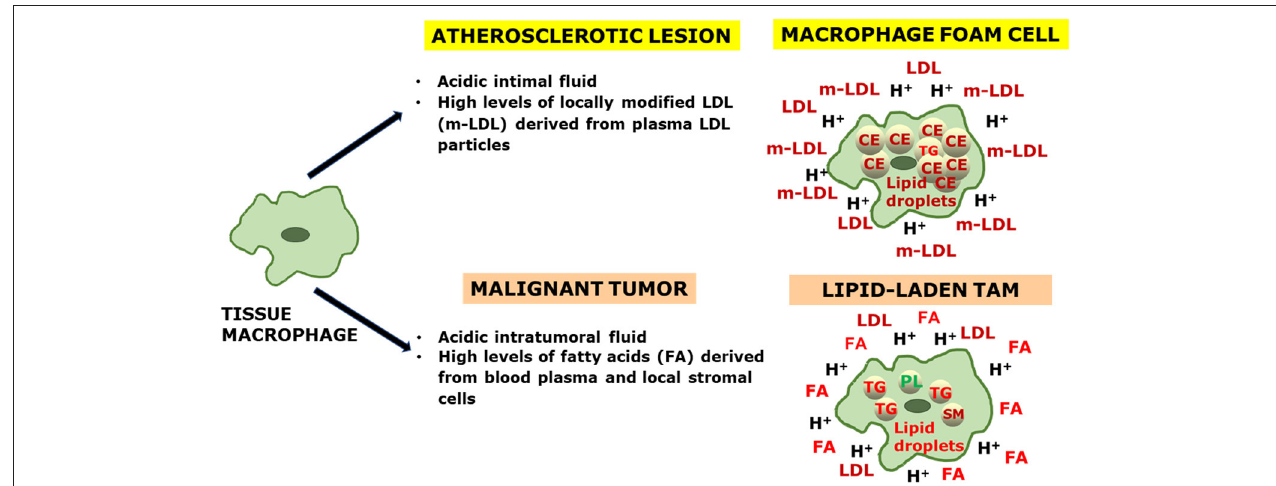
FIGURE 1 | An integrative view of the generation of lipid-laden macrophages in atherosclerosis and cancer. Tissue macrophages (LEFT) are exposed to characteristic microenvironmental conditions present in the extracellular fluids of an atherosclerotic lesion and a malignant tumor (CENTER), which influence the respective lipid cargo of the macrophage foam cells and lipid-laden tumor-associated macrophages (TAMs) (RIGHT). In the extracellular fluid: LDL, low-density lipoprotein; m-LDL, modified low-density lipoprotein; FA, fatty acid; H + , proton. In the intracellular space: CE, cholesteryl ester; TG, triglyceride; PL, phospholipid; SM, sphingomyelin.